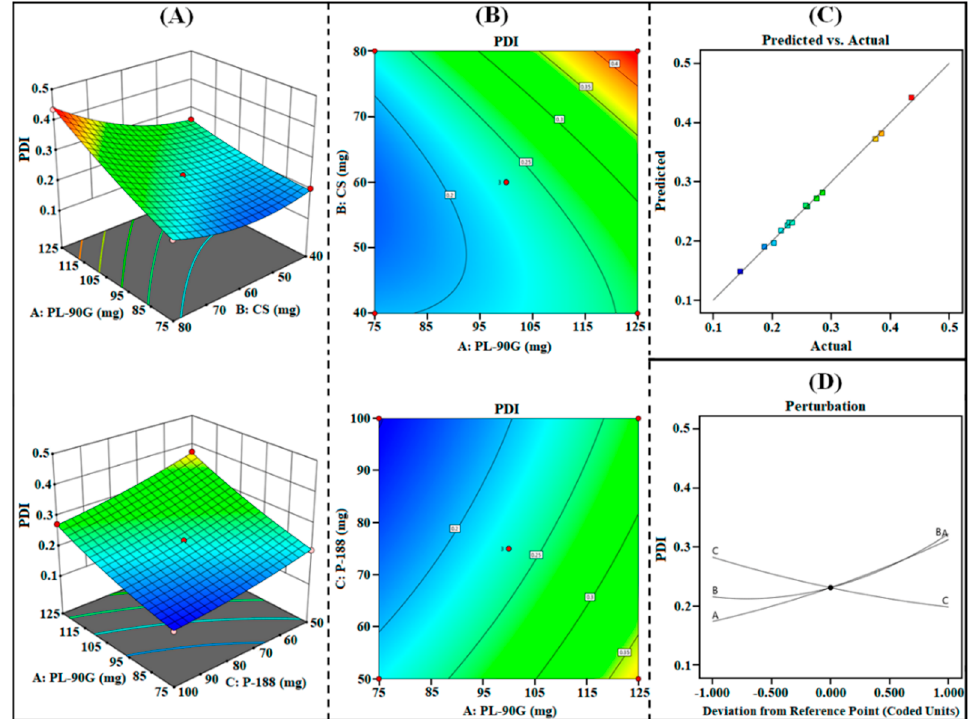
Figure 3. Image representing 3D response surface plots ( A ), contour plots ( B ), predicted vs. actual plot ( C ), and perturbation plot ( D ) representing the influence of independent factors (A = PL-90G; B = CS; C = P-188) on R 2 (PDI) for PPN-LPHNPs.